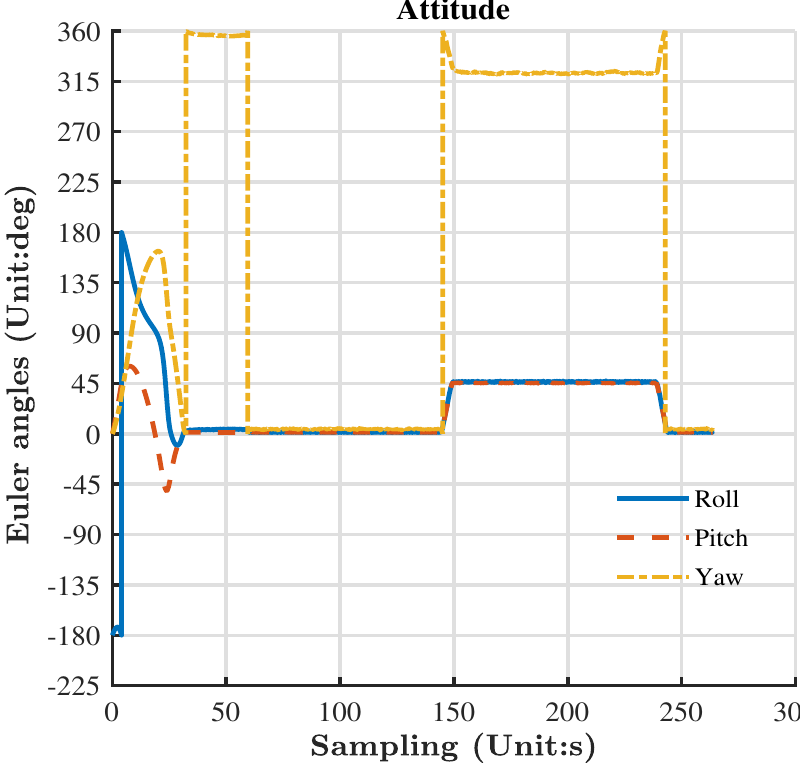
Figure 12. The performance of the Madgwick